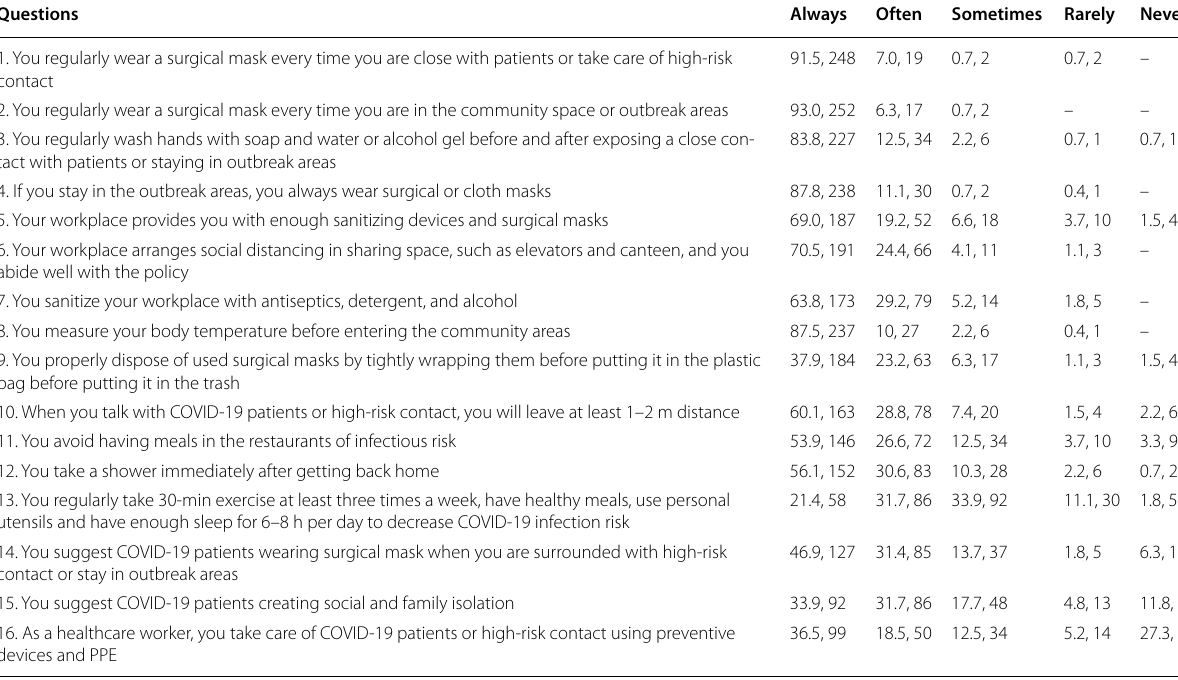
Data presented as percentage,